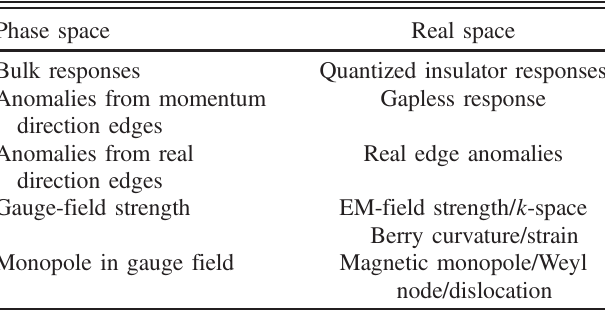
TABLE I. Dictionary for interpreting phase-space quantities in real